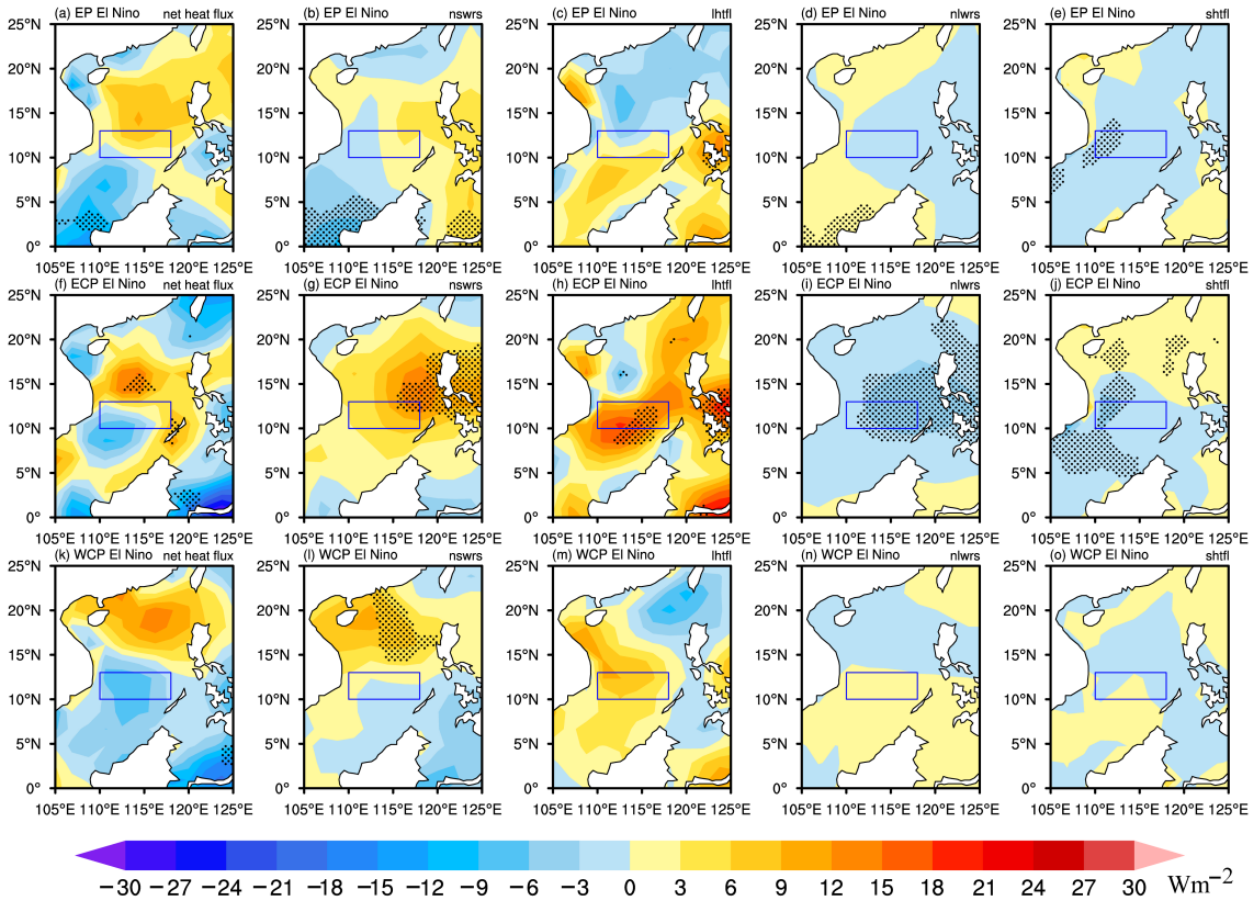
Figure 11. Composite JJA anomalies of net surface heat flux ( a , f , k ), short-wave radiation flux ( b , g , l ), latent heat flux ( c , h , m ), long-wave radiation flux ( d , i , n ) and sensible heat flux ( e , j , o ) (W · m − 3 ) over the SCS for EP El Niño ( a – e ), ECP El Niño ( f – j ) and WCP El Niño ( k – o ). The stippled areas represent the values exceeding the 90% significance level. Rectangles represent the CT region. Long-wave radiation, latent heat flux and sensible heat flux are upward positive and short-wave radiation is downward positive.